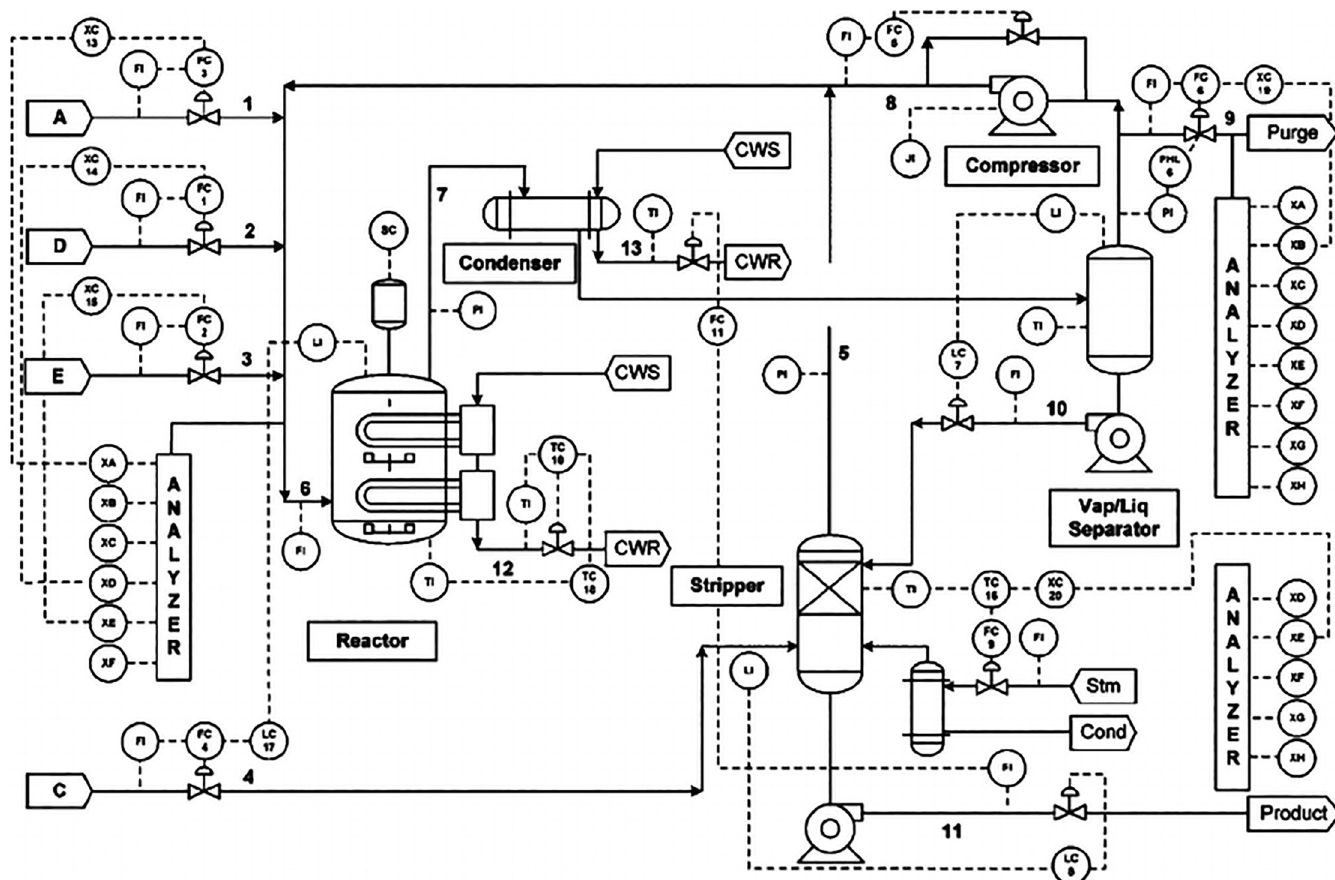
Fig 5. A diagram of the Tennessee Eastman process simulator